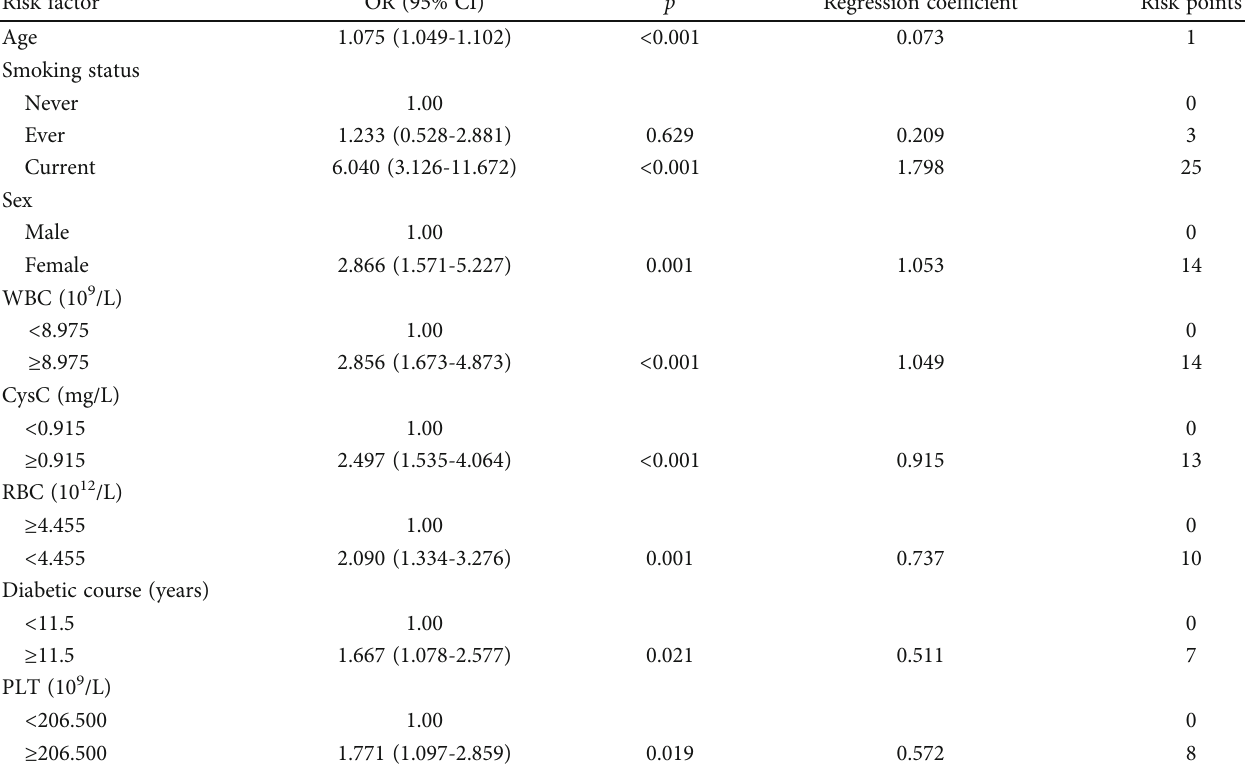
Table 4: Main risk factors associated with increased risk of developing